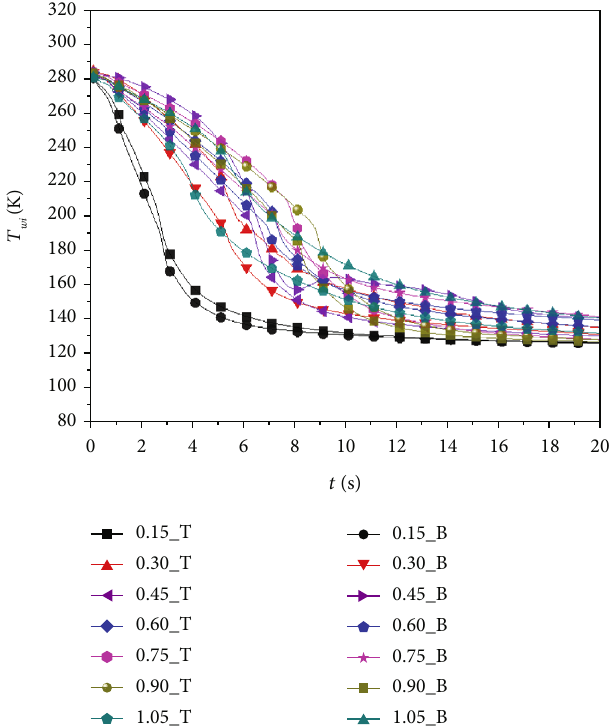
Figure 7: Data curves for Exp. 5 ( _ m = 0 : 564 kg/s , p